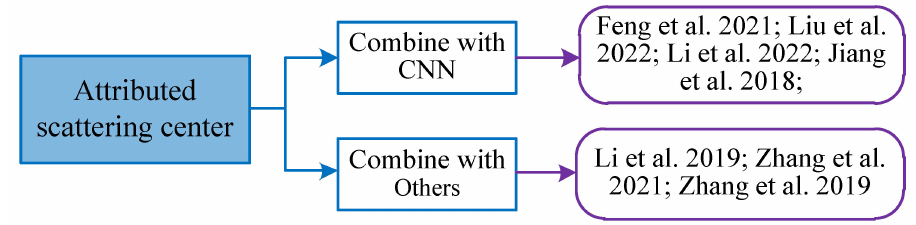
Figure 26. The usage of attributed scattering center in SAR ATR